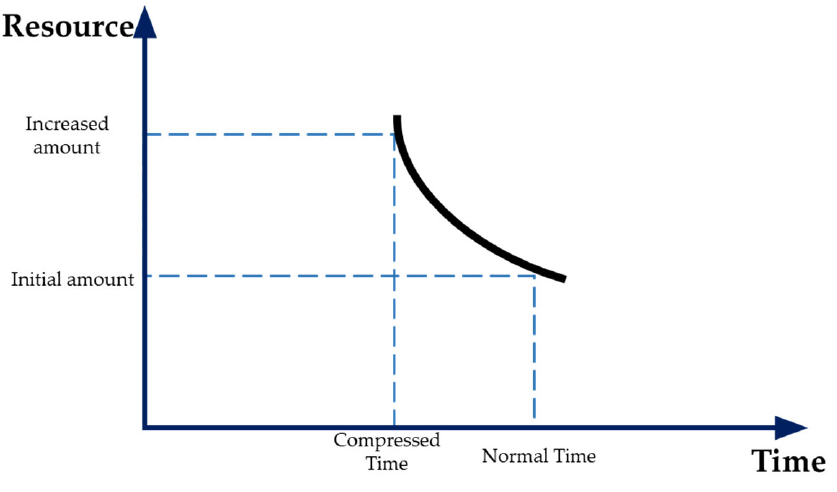
Figure 8. The trade-off between resources and Figure 8. The trade ‐ off between resources and time.